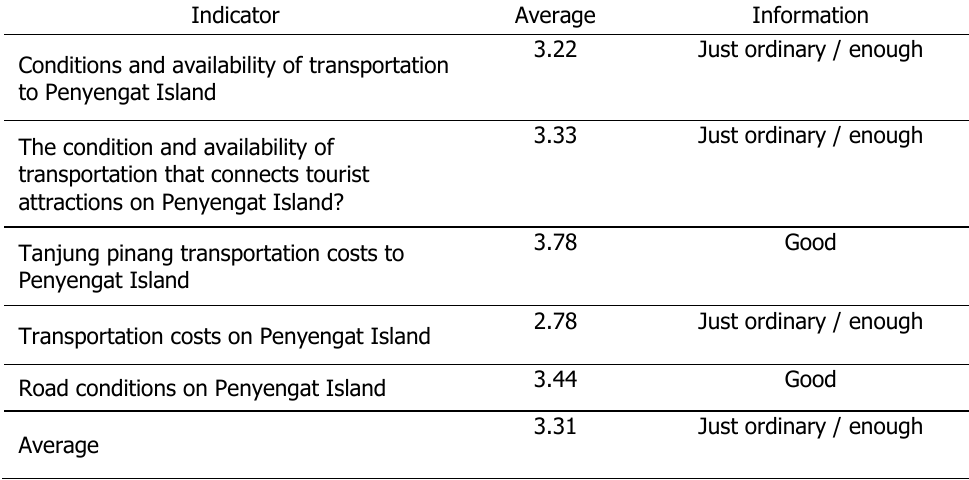
Table 5 . Accessibility attribute assessment